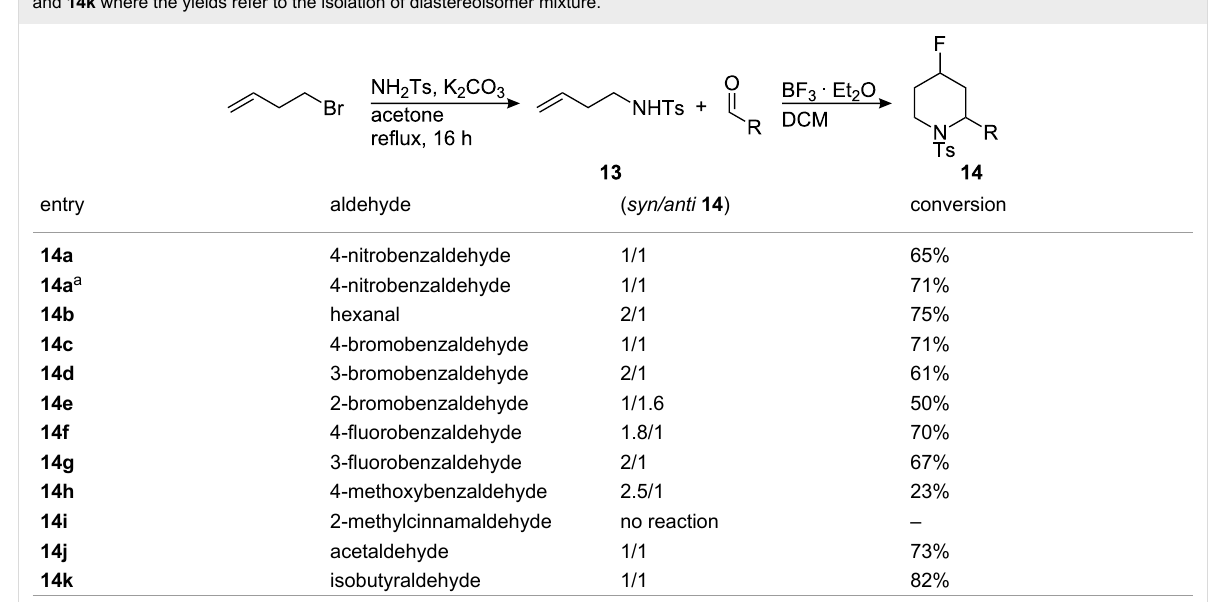
Table 5: Aza-Prins reaction between N -homoallyl- N -tosylamine ( 13 ) and aldehydes 14 in the presence of BF 3 ·OEt 2 . Reaction conditions (except entry 2): Amine 13 (1 equiv), aldehyde (1 equiv), BF 3 ·OEt 2 for 36 h at rt; yield refers to the isolation of both stereoisomers in each case except for entry 14j and 14k where the yields refer to the isolation of diastereoisomer